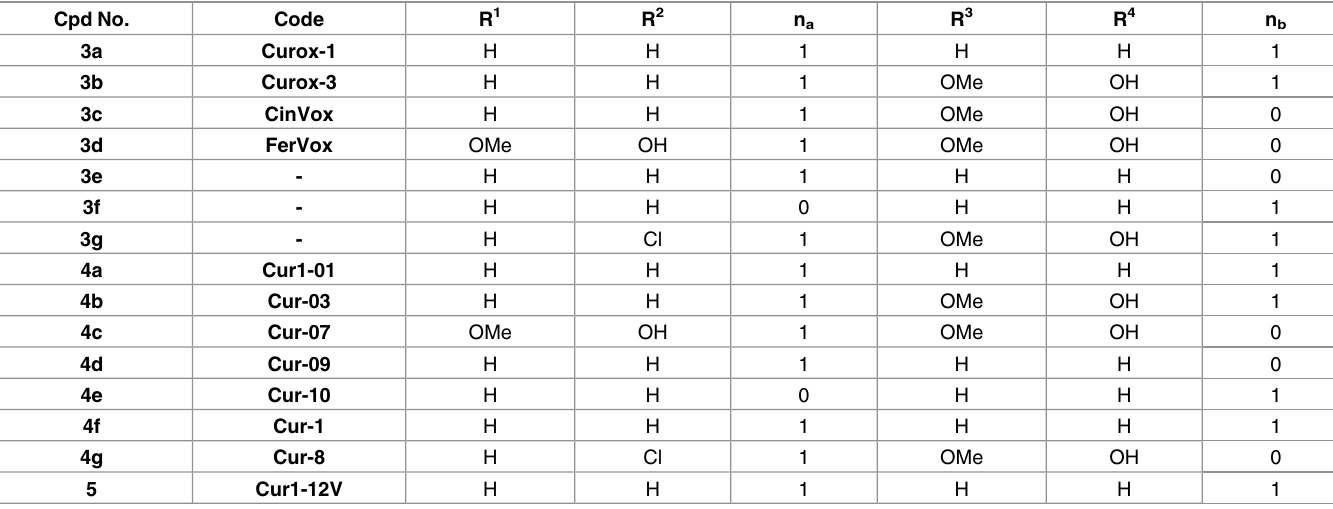
Table 1. Structure and codes of the synthesized oxazolones and imidazolones. Cpd No.